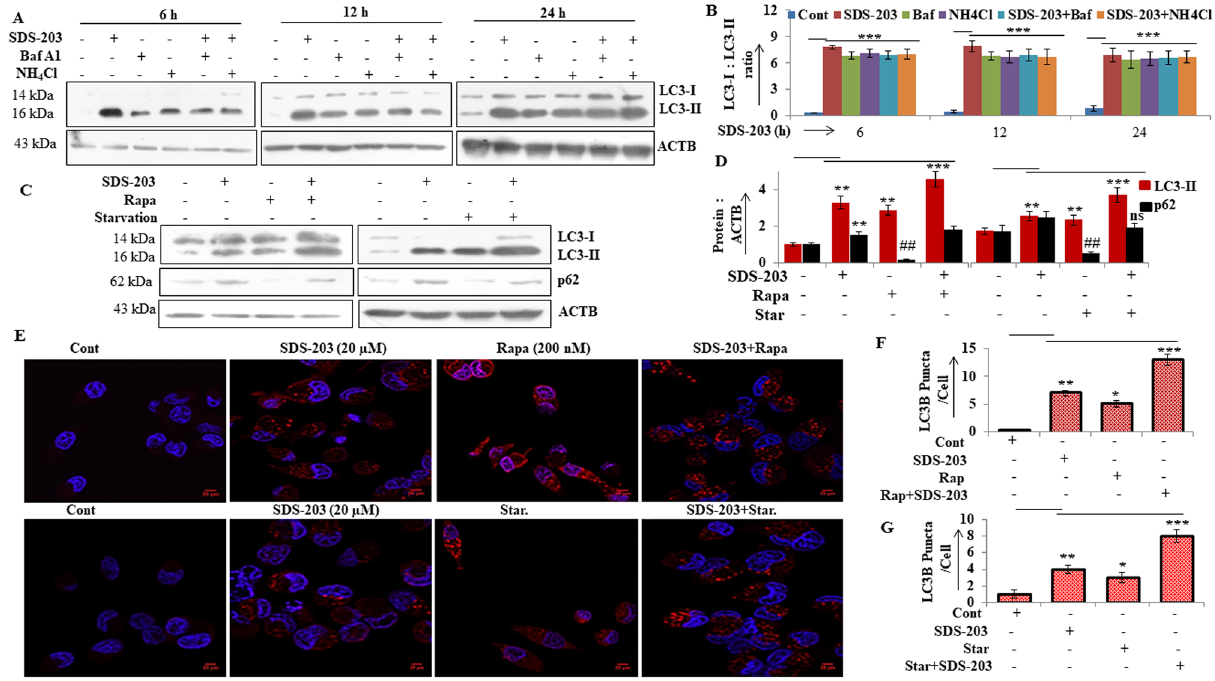
Figure 4. SDS-203 initiates incomplete autophagy by inhibiting autophagy flux. ( A , B ) MIA PaCa-2 cells were treated with SDS-203 (20 μM) for 6, 12 and 24 h in presence or absence of bafilomycin A1 (80 nM) or NH 4 Cl (10 mM) and LC3 turnover was detected and quantified by western blot analysis. ( C , D ) SDS-203 (20 µM) treated MIA PaCa-2 cells were allowed to grow in the presence or absence of rapamycin (200 nM, 12 h) or starved for (12 h), followed by protein expression examination of LC3-II and p62. ( E – G ) MIA PaCa-2 cells were incubated with SDS-203 in the presence or absence of rapamycin or starvation and the effects on LC3-II expression was visualized using confocal microscopy, LC3-II puncta quantification was done by using ImageJ software; the panel represents the set of images of at least three independent biological replicates. Statistics, Student’s t test * p < 0.05, **or## p < 0.01, *** p < 0.001 vs. control (0.1%